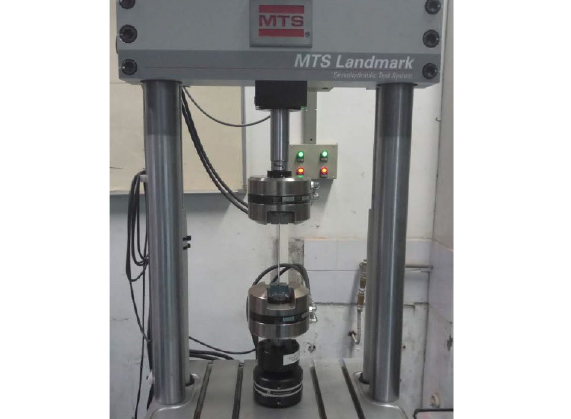
Figure 6 MTS stretching